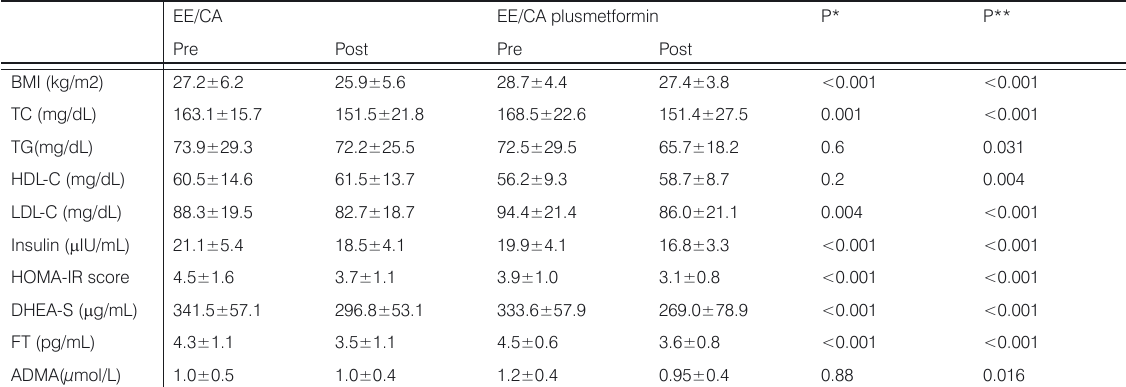
Table 2. Comparisons of pre- and post-treatment clinical and laboratory characteristics in treatment groups (mean±SD) (P* Before vs after therapy for EE/CA group; P** Before vs after therapy for EE/CA plus metformin group